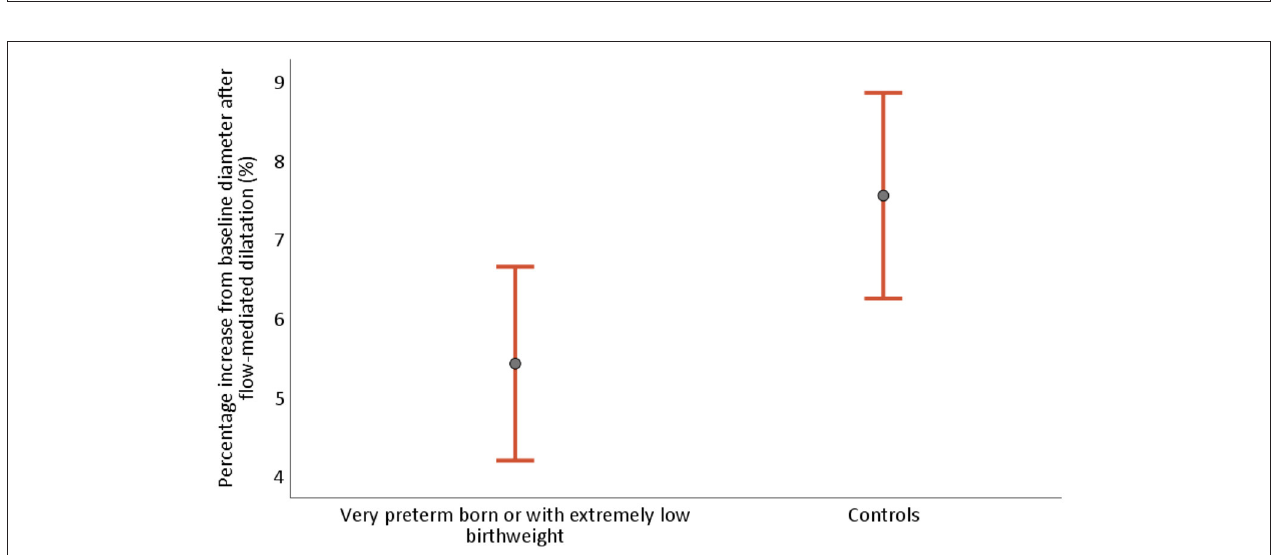
FIGURE 4 | Percentage flow-mediated dilatation (FMD) of the brachial artery from baseline in young adults born very preterm or with extremely low birthweight (PB/ELBW) and term-born controls, presented as mean with 95% CI. Percentage FMD was 5.4% (95% CI 4.2, 6.6) for PB/ELBW and 7.5% (95% CI 6.2, 8.9) for